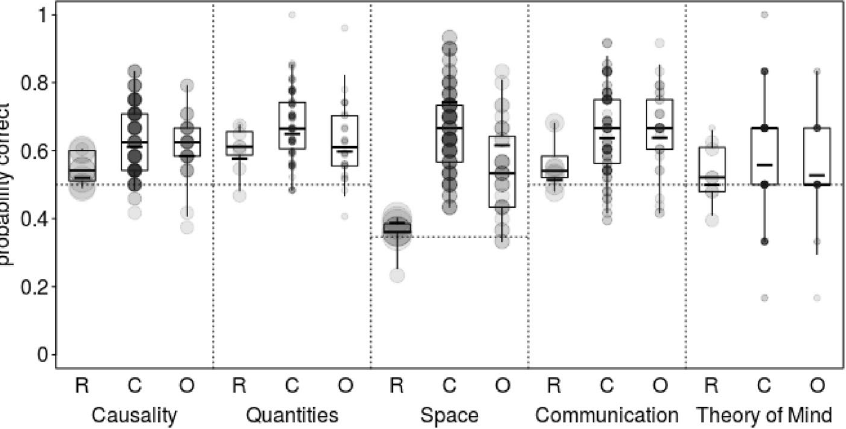
Figure 5 Proportions of correct responses as a function of species. The figure shows the proportions of correct responses as a function of species (R: ravens; C: chimpanzees; O: orang-utans) and cognitive scale. The area of the dots represents the number of tests per individual and proportion correct (N = 2 to 40); darker dots represent tied observations. Indicated are median (horizontal lines), quartiles (boxes), and percentiles (2.5 and 97.5%, vertical lines). The short thick horizontal lines depict the fitted model. The doted horizontal lines depict chance